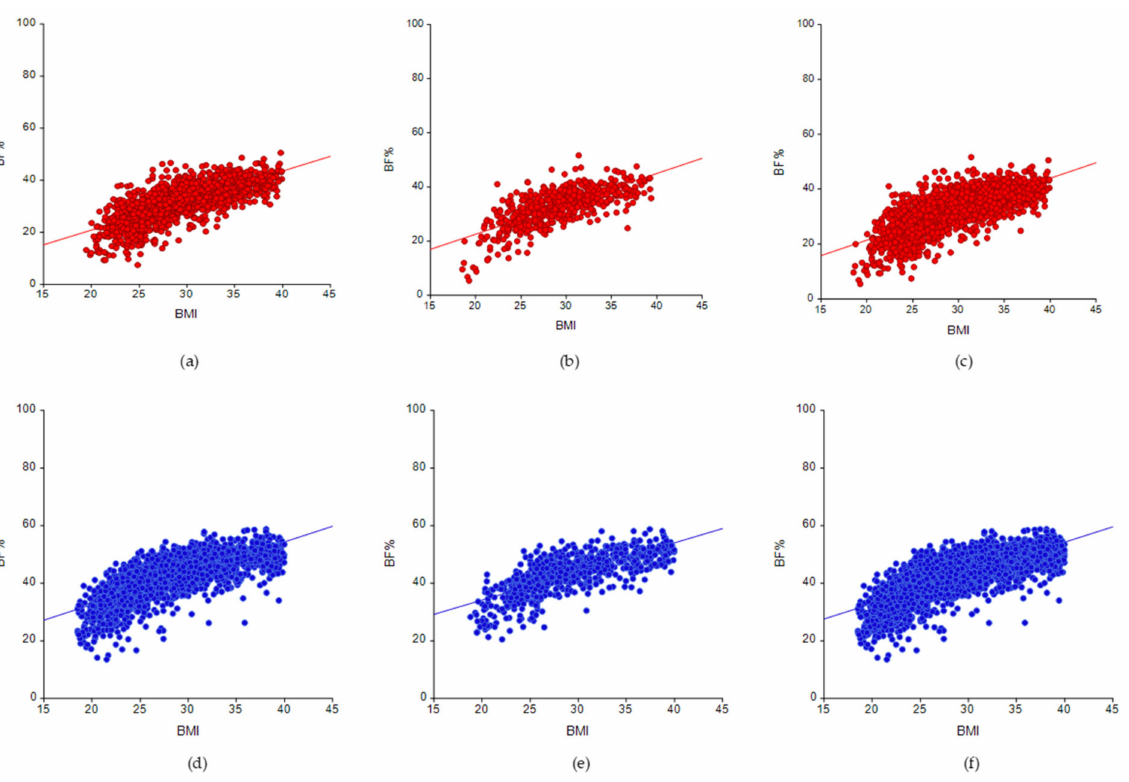
Figure 1. BMI versus BF% by gender and age groups (BF—body fat percentage; BMI—body